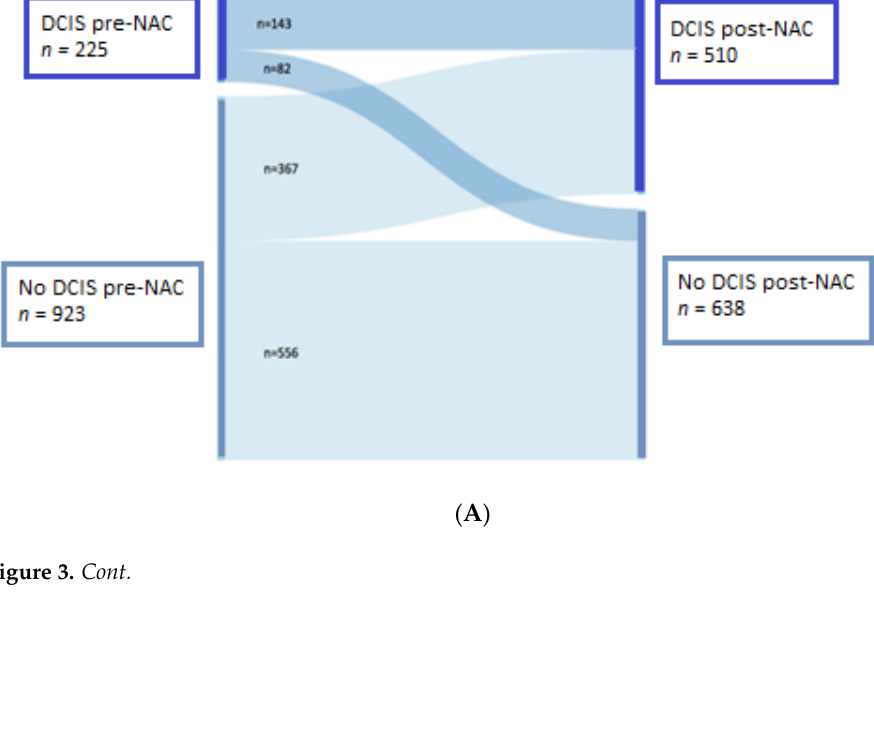
Figure 2. Presence of a DCIS component in post-NAC breast cancer surgical specimens.